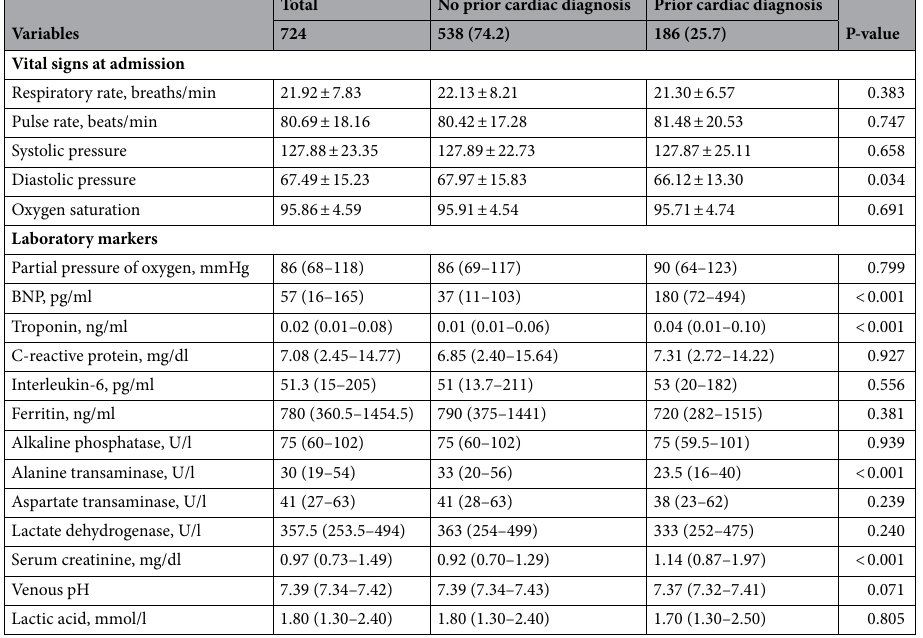
Table 2. Summary of vital signs and laboratory markers at index COVID-19 hospitalization stratified by prior cardiac diagnosis. Mean ± standard deviation or median (interquartile range) presented. BNP B-natriuretic